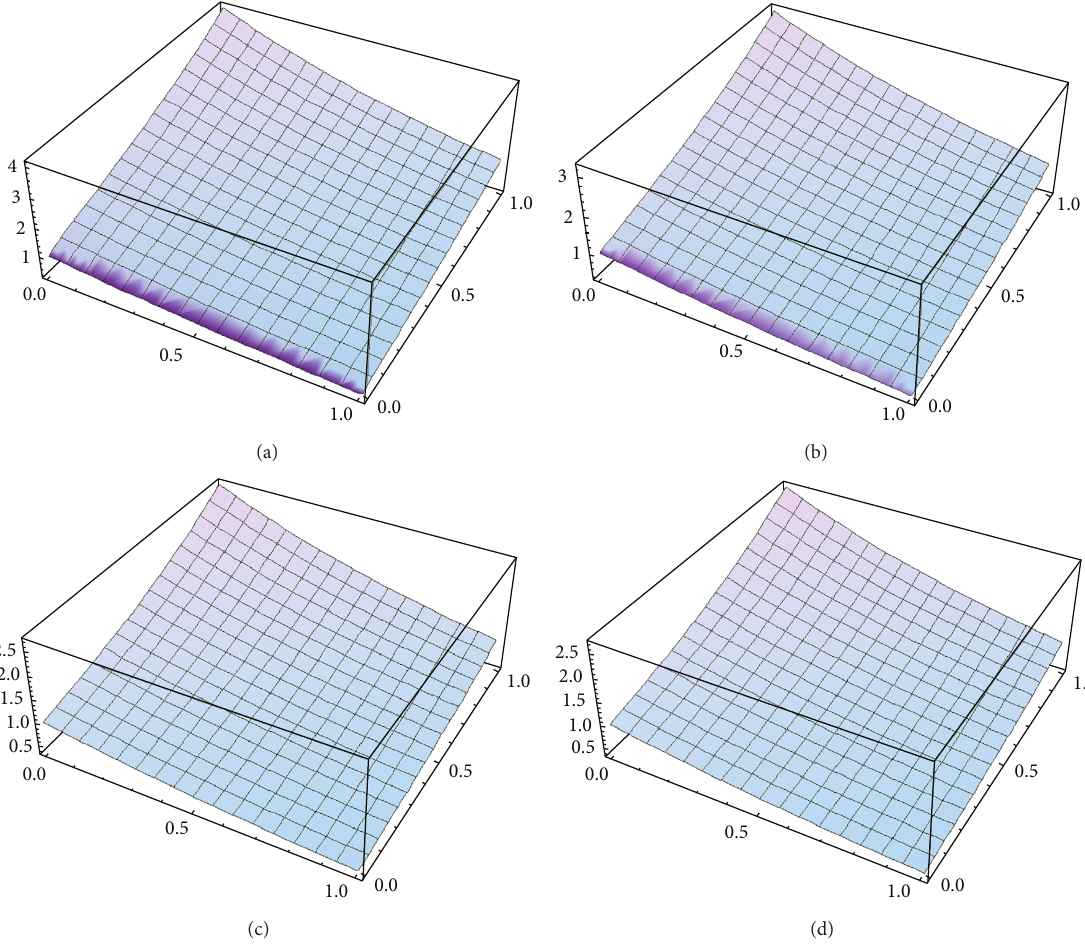
Figure 1: (a) 5-term approximate solution for (18a) and (18b), in case 𝑥 : 0 → 1 , 𝑡 : 0 → 1 , and 𝛼 = 0.6 . (b) 5-term approximate solution for (18a) and (18b), in case 𝑥 : 0 → 1 , 𝑡 : 0 → 1 , and 𝛼 = 0.8 . (c) 5-term approximate solution for (18a) and (18b), in case 𝑥 : 0 → 1 , 𝑡 : 0 → 1 , and 𝛼 = 1 . (d) Exact solution for (18a) and (18b), in case 𝑥 : 0 → 1 , 𝑡 : 0 → 1 , and 𝛼 = 1 .